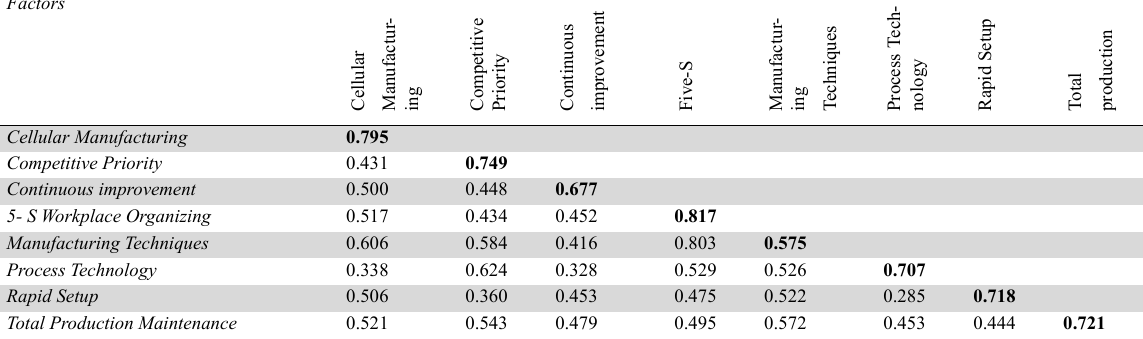
The results of correlation among different variables Factors